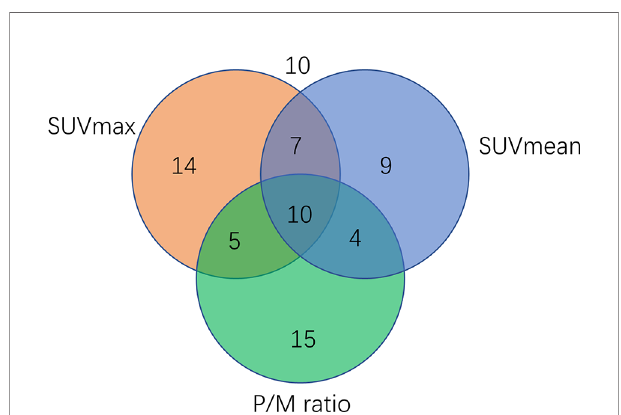
FIGURE 5 | Venn diagram showing the number of PCa patients (n=74) tested positive for single parameters or parameter combination. A total of 14 samples were positive for SUVmax, nine were positive for SUVmean, 15 were positive for P/M ratio, and 10 were positive for all